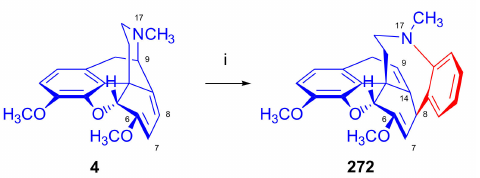
Figure 74. Reaction of thebaine with in situ generated benzyne. Reagents and conditions : (i): (1) antranilic acid, trichloroacetic acid, THF, isoamyl nitrite, 0 ◦ C, 2 min, (2) 20 ◦ C, 1.5 h, 3. dichloromethane, reflux, 30 min.